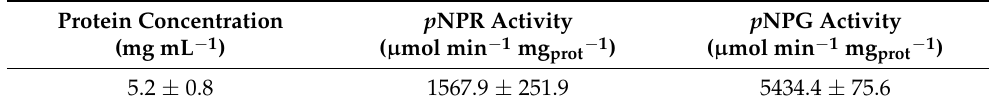
Table 1. Characterization of